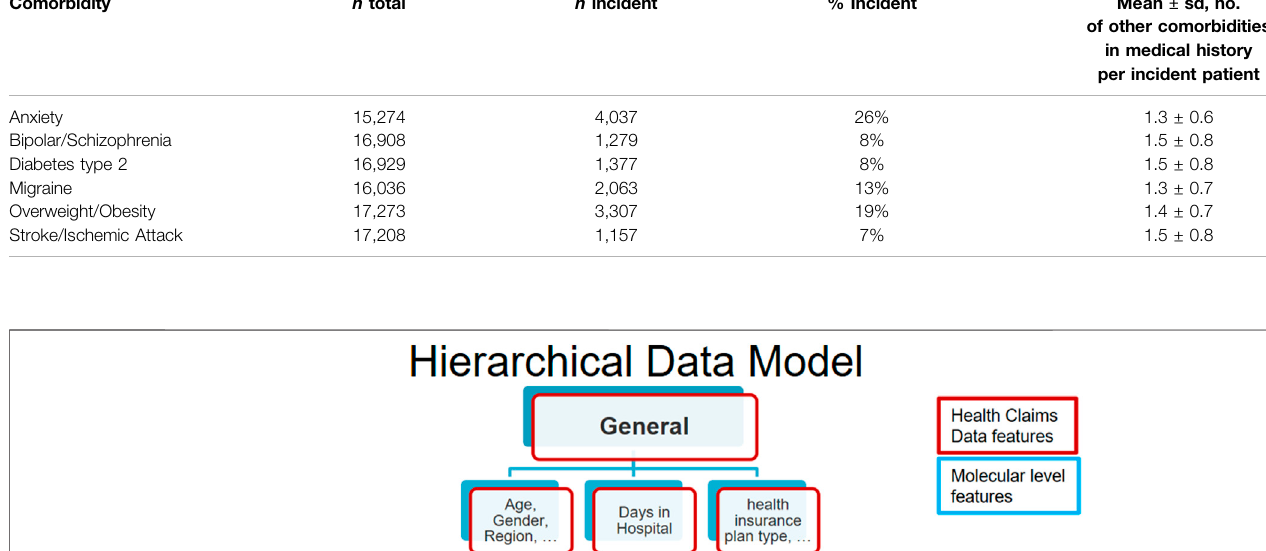
TABLE 1 | Proportion of incident patients by comorbidity. Comorbidity